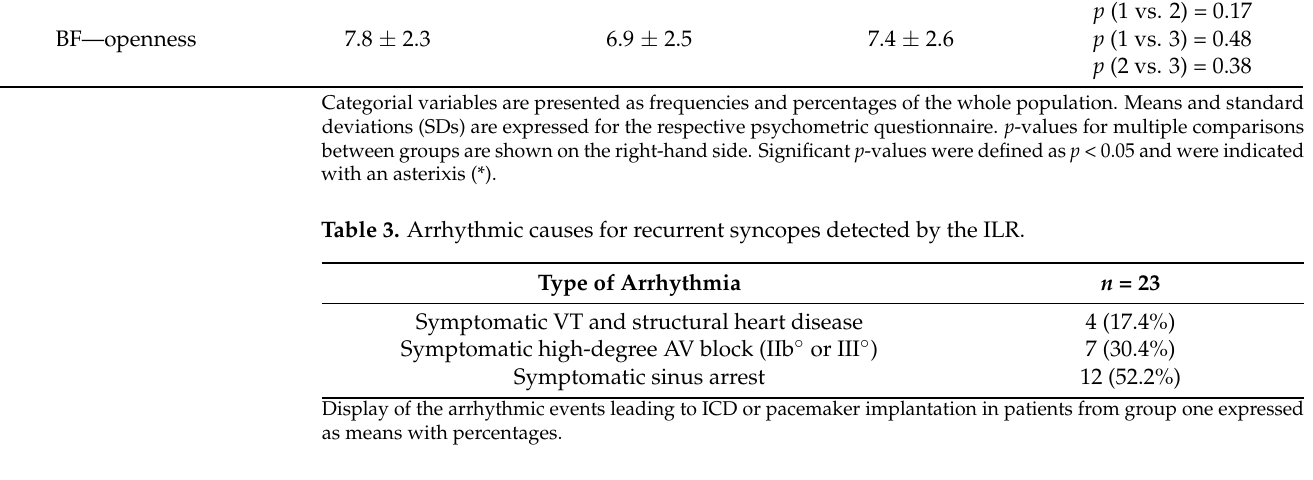
Table 4. Results of the multivariable logistic regression